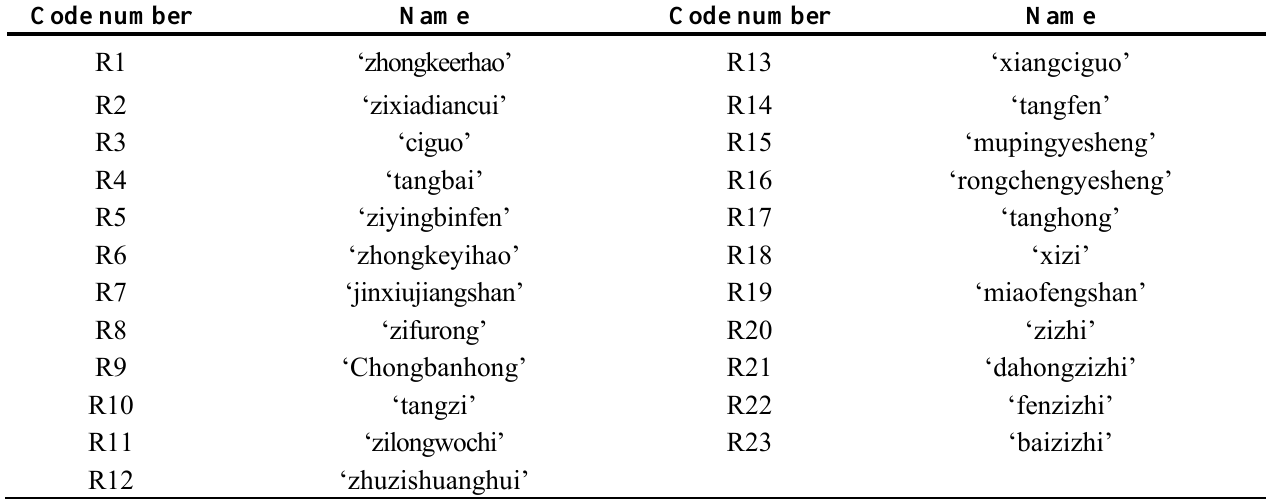
Table 1. Code numbers and names of the tested R. rugosa